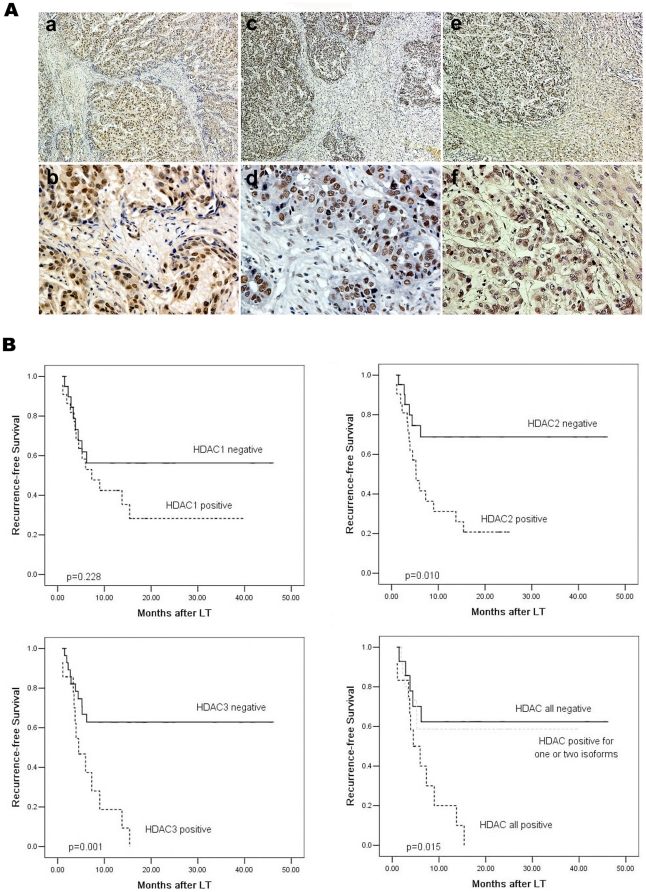
The role of class I HDAC expression in HCC patients receiving liver transplantation.(A) Representative HDAC1-positive (a,b), HDAC2-positive(c,d) and HDAC3-positive(e,f) samples are shown at 100× (a,c,e) and 400× magnification (b,d,f). HDAC negative (IRS from 0 to 6) and HDAC positive (IRS higher than 6). (B) Kaplan-Meier curves estimates the recurrence-free survival rates according to expression patterns of HDAC1, 2, 3, and combined HDAC expression in the cohort.